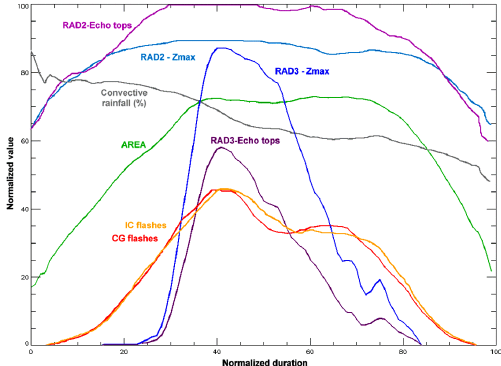
Fig. 8. Normalized plots of 50 percentile curves (medians) of dif- ferent parameters: radar reflectivity echo tops (RAD2 and RAD3), Z max (RAD2 and RAD3), thunderstorm area, thunderstorm convec- tive rainfall, and IC and CG flash